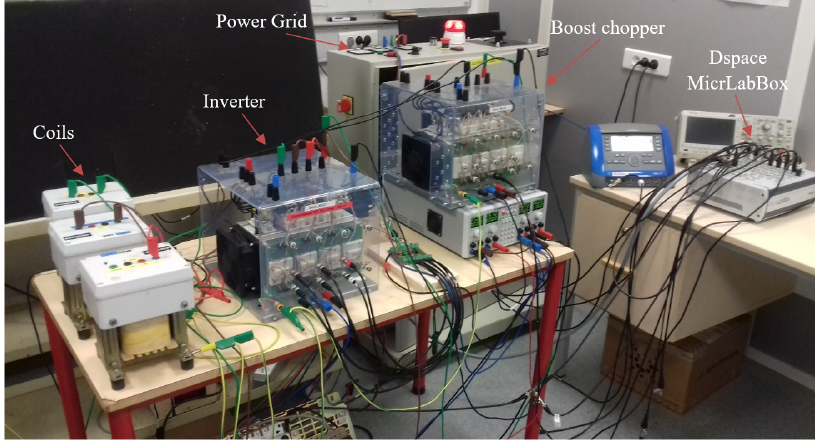
Figure 8. The experimental setup of the system.